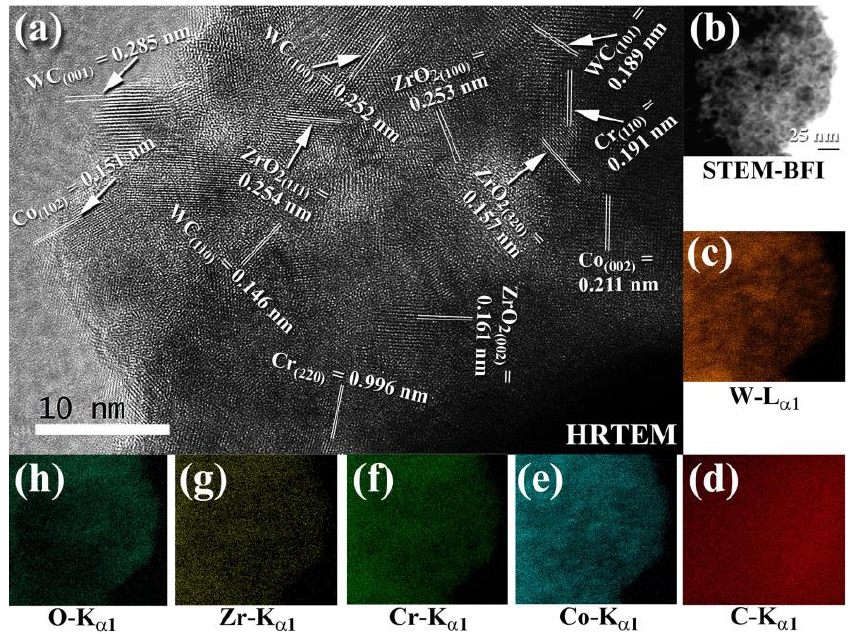
Figure 26. ( a ) HRTEM and ( b ) STEM-BF pictures of nanocomposite powders 93(93-WC/7 wt. % (10Co/4Cr))/7 wt. % ZrO 2 produced after 50 h of ball milling. The equivalent X-ray elemental mappings for ( c ) W-L a1 , ( d ) C-K a1 , ( e ) Co-K a1 , ( f ) Cr-K a1 , ( g ) Zr- K a1 , and ( h ) O-K a1 have been established. Figure 27a is a FESEM micrograph of the cross-sectional view of 93(93-WC/7 wt. % (10Co/4Cr)) /7 wt. % ZrO 2 powders after 50 h of MM and then consolidated into bulk